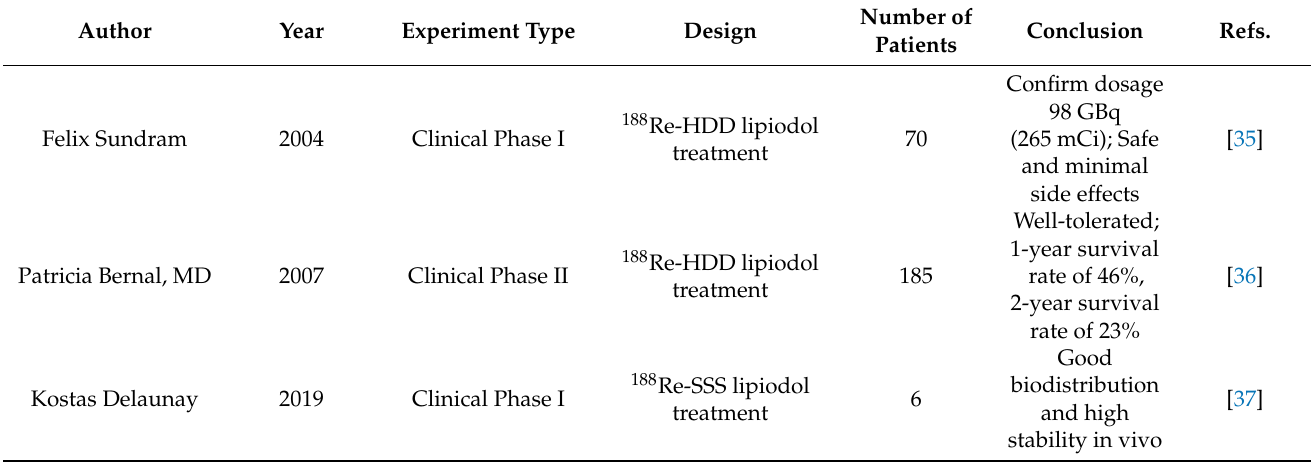
Table 3. Advances for the treatment of HCC with 188 Re-lipiodol